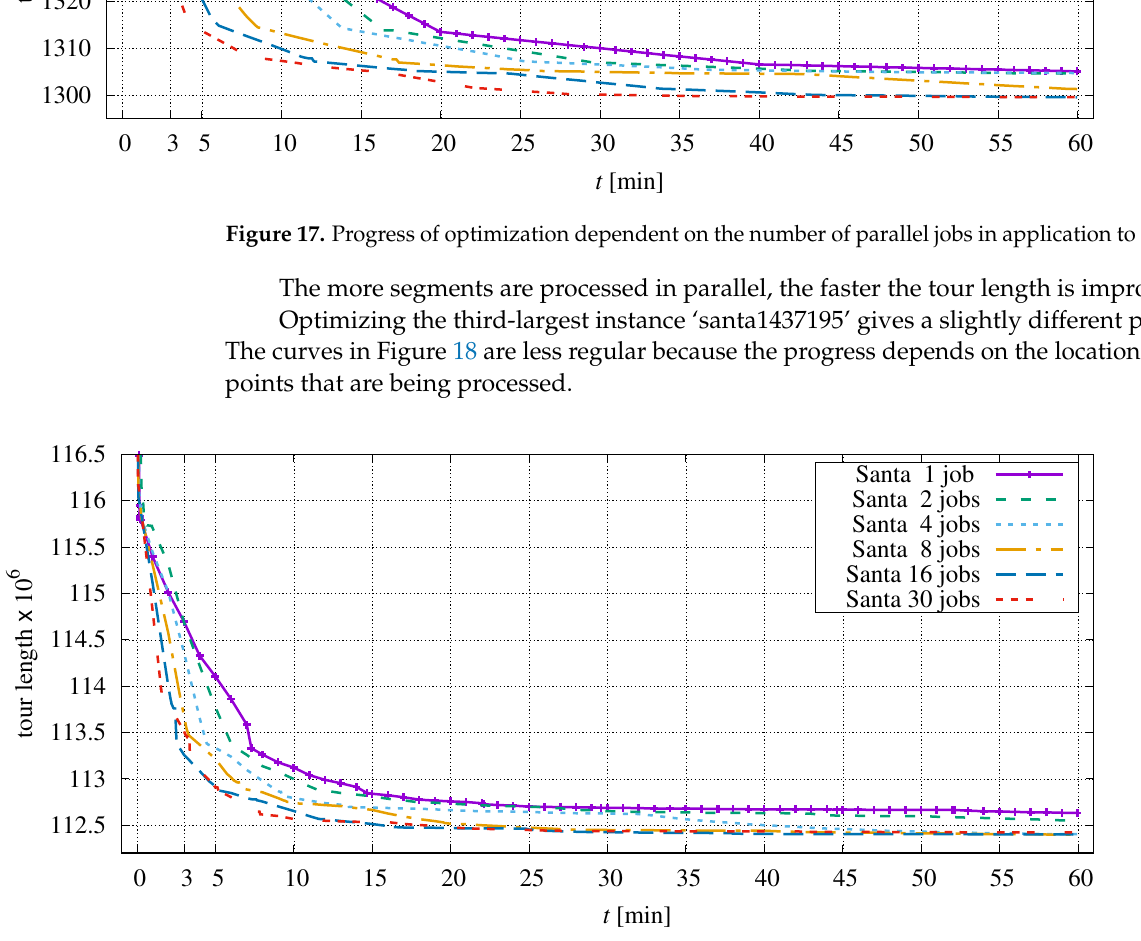
Figure 18. Progress of optimization dependent on the number of parallel jobs in application to